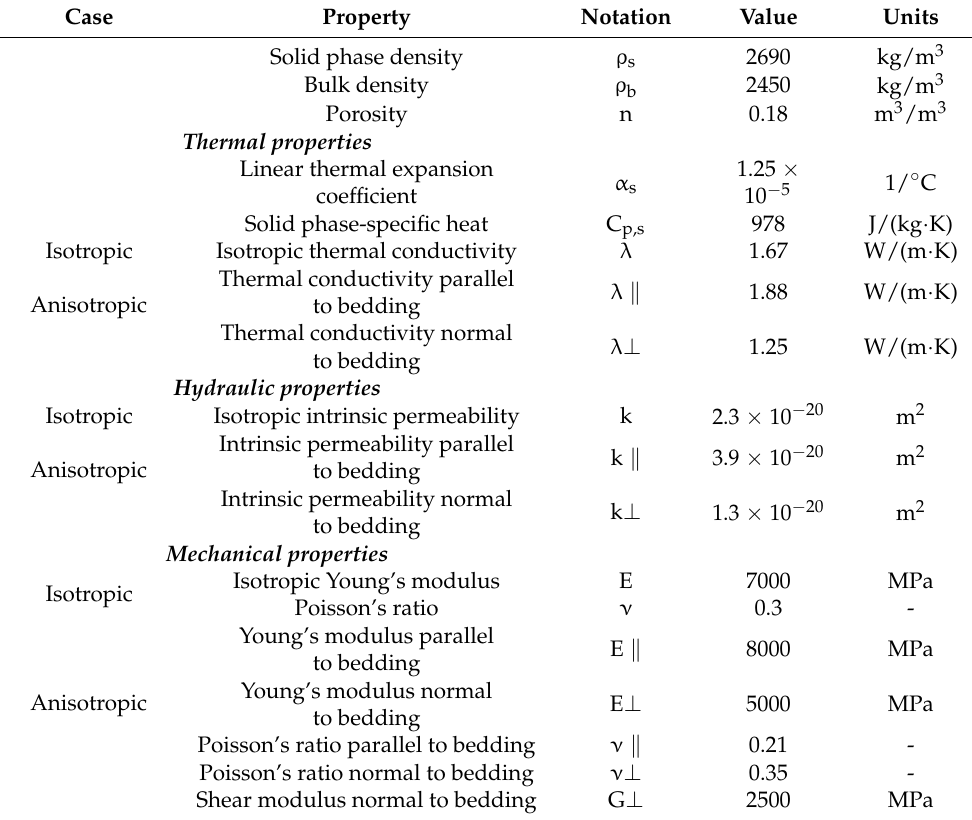
Table 4. COx THM